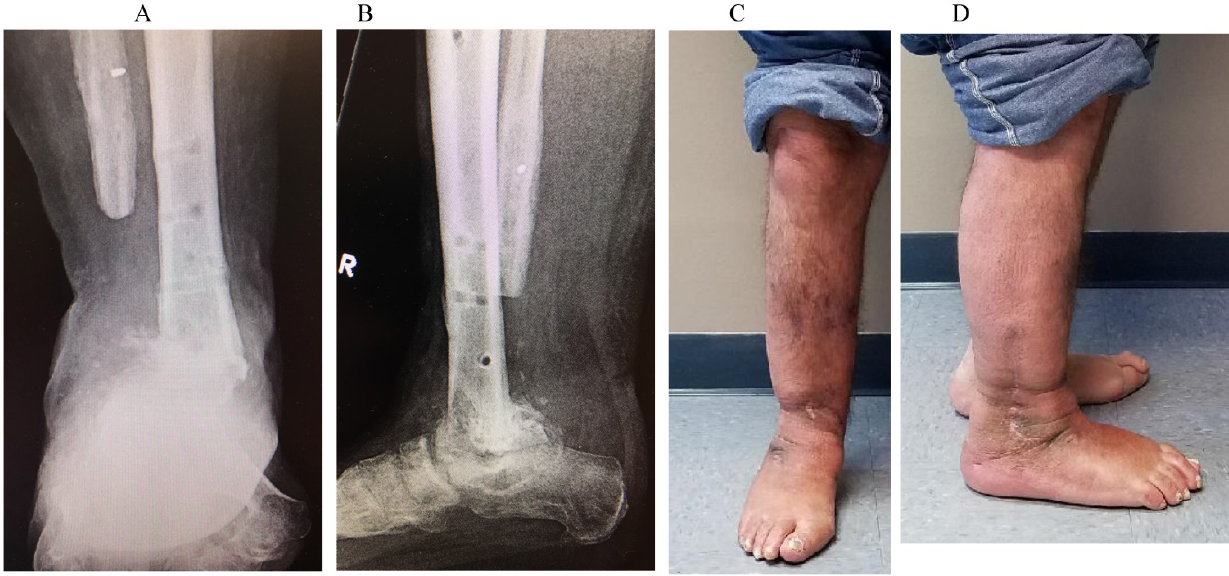
Figure 5: AP (A) and Lateral (B) radiographs with same day clinical appearance of extremity (C & D) 1-year following fusion demonstrating a solid tibiotalar fusion mass and well healed incisions with no evidence of infection